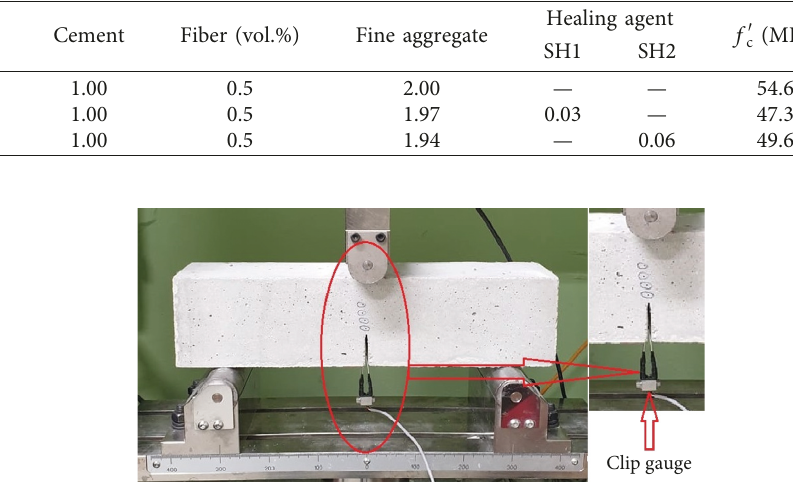
Figure 1: Three-point bending test setup.